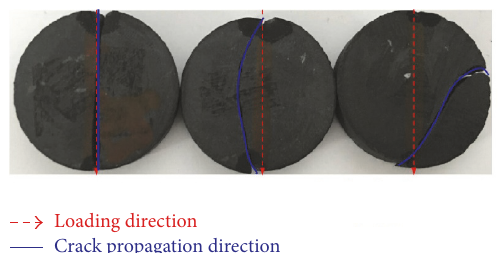
Figure 9: Three failure modes of shale in the Brazilian splitting test.